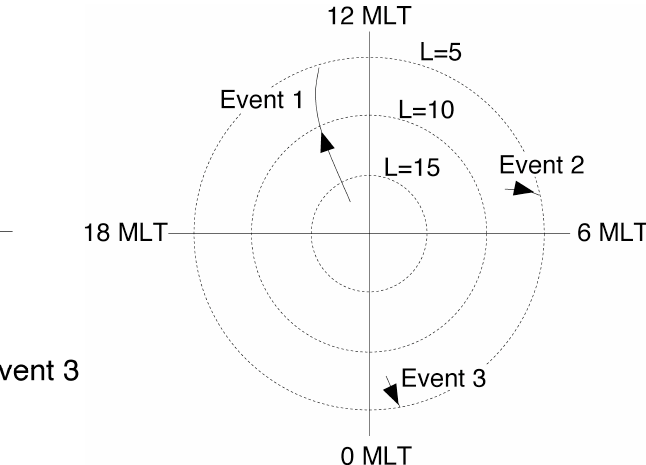
”, NOT ” perigee of ∼ 3 R ”. E E